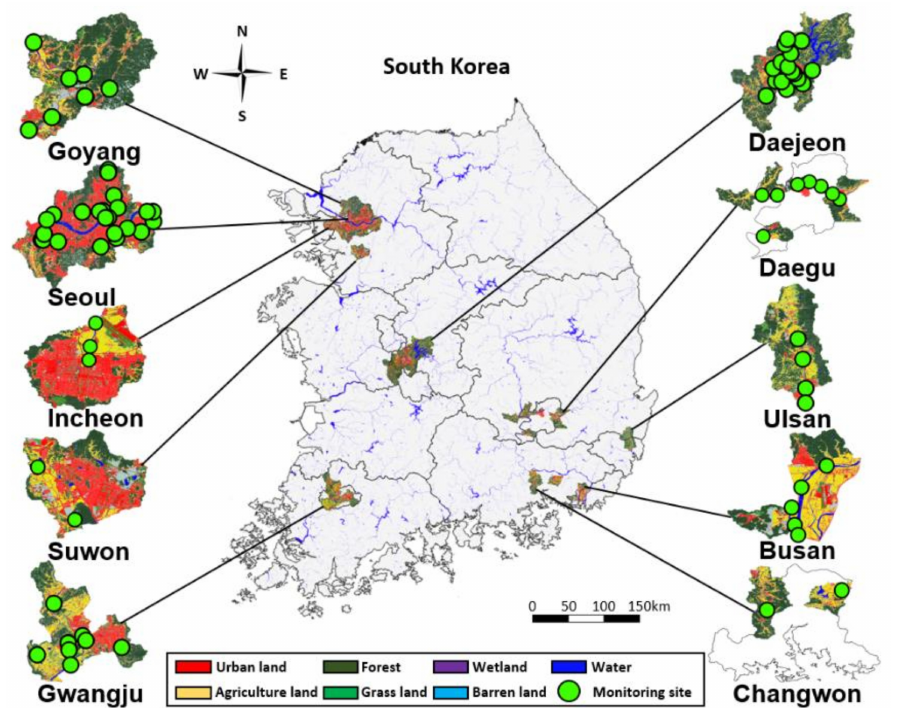
Figure 1. Location of monitoring sites in ten major metropolitan areas of South